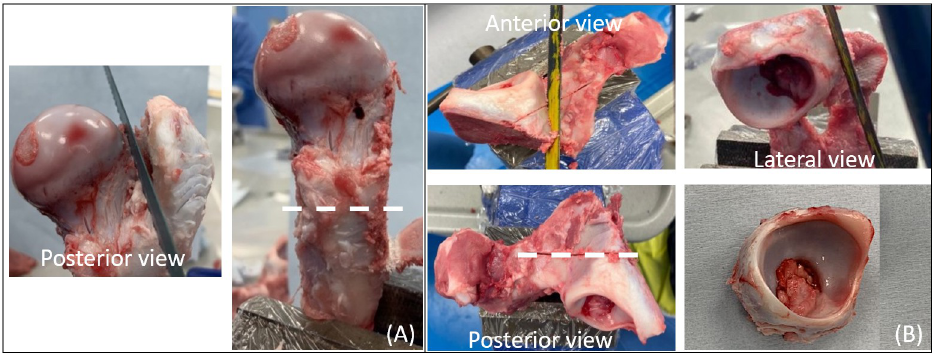
Fig 2. Preparation of porcine hip joint. (A) Removal of the grater trochanter and cut on the femoral diaphysis. Posterior view of the proximal femur indicating the resection of the greater trochanter and the positon for the transversal cut on the femoral shaft. (B) Resection of the pelvic bones. Lateral, anterior and posterior views indicating the three periacetabular cuts executed at approximately 15 mm from the acetabular